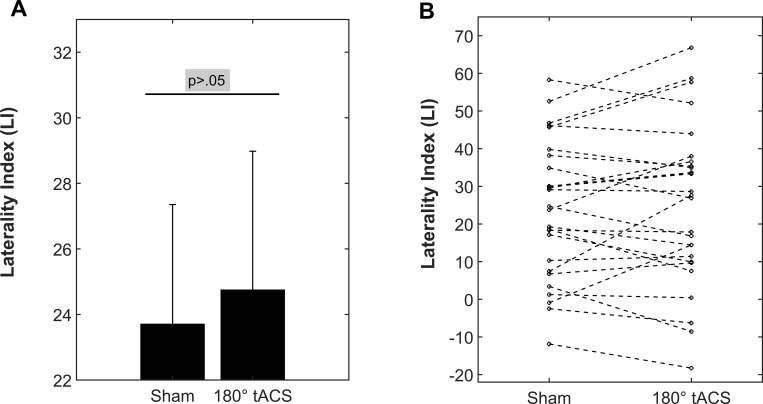
Behavioral results.Laterality Index (LI): Positive values indicate a bias towards right ear reports. (A) 180° tACS at 40Hz does not increase the LI (one-sided t-test for paired-samples, t(25) = 0.597, p = .278, d = 0.05). The error bars depict the standard error of the grand average behavioral performance (LI) during both conditions (mean ± SEM). (B) The individual behavioral performances (N = 26) during both conditions. The dashed lines highlight the directionality of the individual modulations (up: increase of LI; down: decrease of LI).